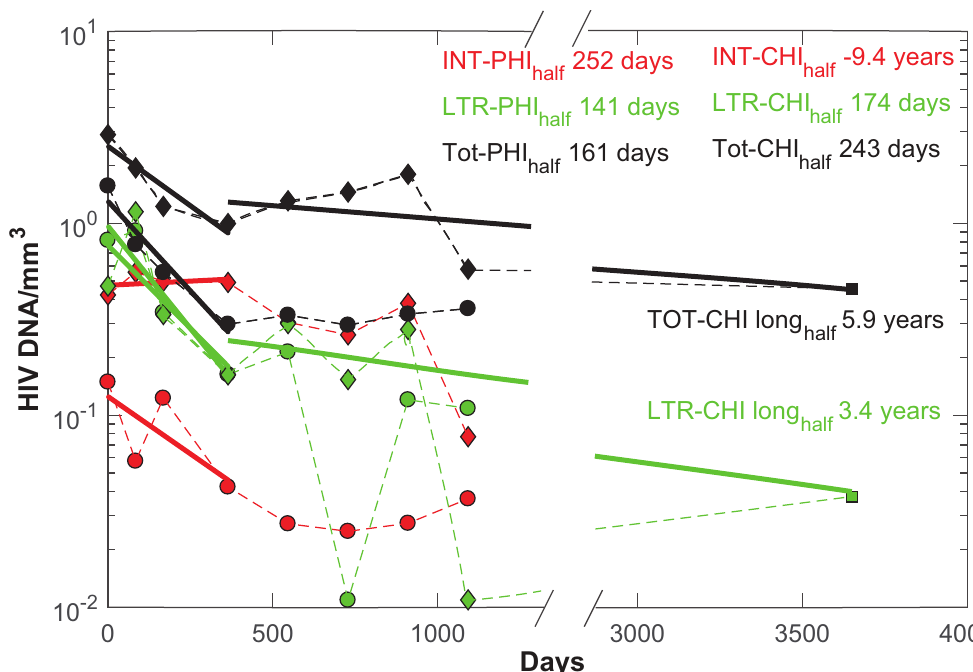
Fig 1. Median HIV DNA per mm 3 changes over time, relative to commencement of ART, for PHI (circles) and CHI (diamonds). Note the break in the time axis and the regressionlines betweendays 1000 and 3000. Regressionlines for each HIV DNA component over the first year are shown (solid lines in the same color as the markers), as well as the corresponding half-lives. Assay values of total HIV DNA/ mm 3 are shown as black markers, 2-LTR HIV DNA/ mm 3 as green markers, and integratedHIV DNA/ mm 3 as red markers. The two lowest 2-LTR markers are due to some of the individualvalues being belowthe assay limit of detection as well as missing CD4+ T cell counts at these later time points. Only considering the 2-LTR HIV DNA values from year 1 for CHI (but omitting the low final value) and for the year 10 time point gives a half-life of decay of 3.4 years, considerably slower than estimates of memory cell divisionhalf-life of 22 weeks but consistent with the longerdivision half-life of na ï vecells (3.5 years) [26]. Total HIV DNA from year 1 for CHI exhibiteda 5.9 year half-life. Integrated HIV DNA increasedfor the CHI group over the first year leadingto a